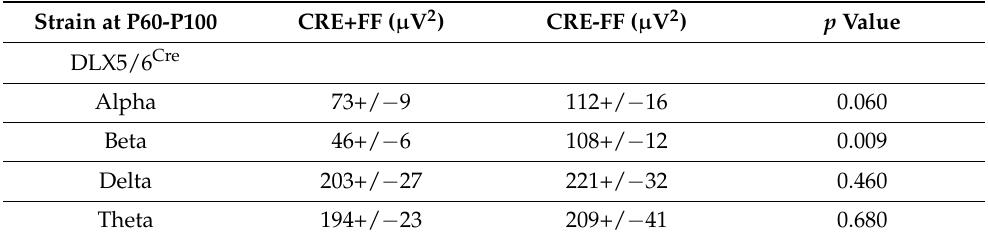
Table 5. EEG Power of Interneuron Cell Specific Semaphorin 3F Deletion Mice.